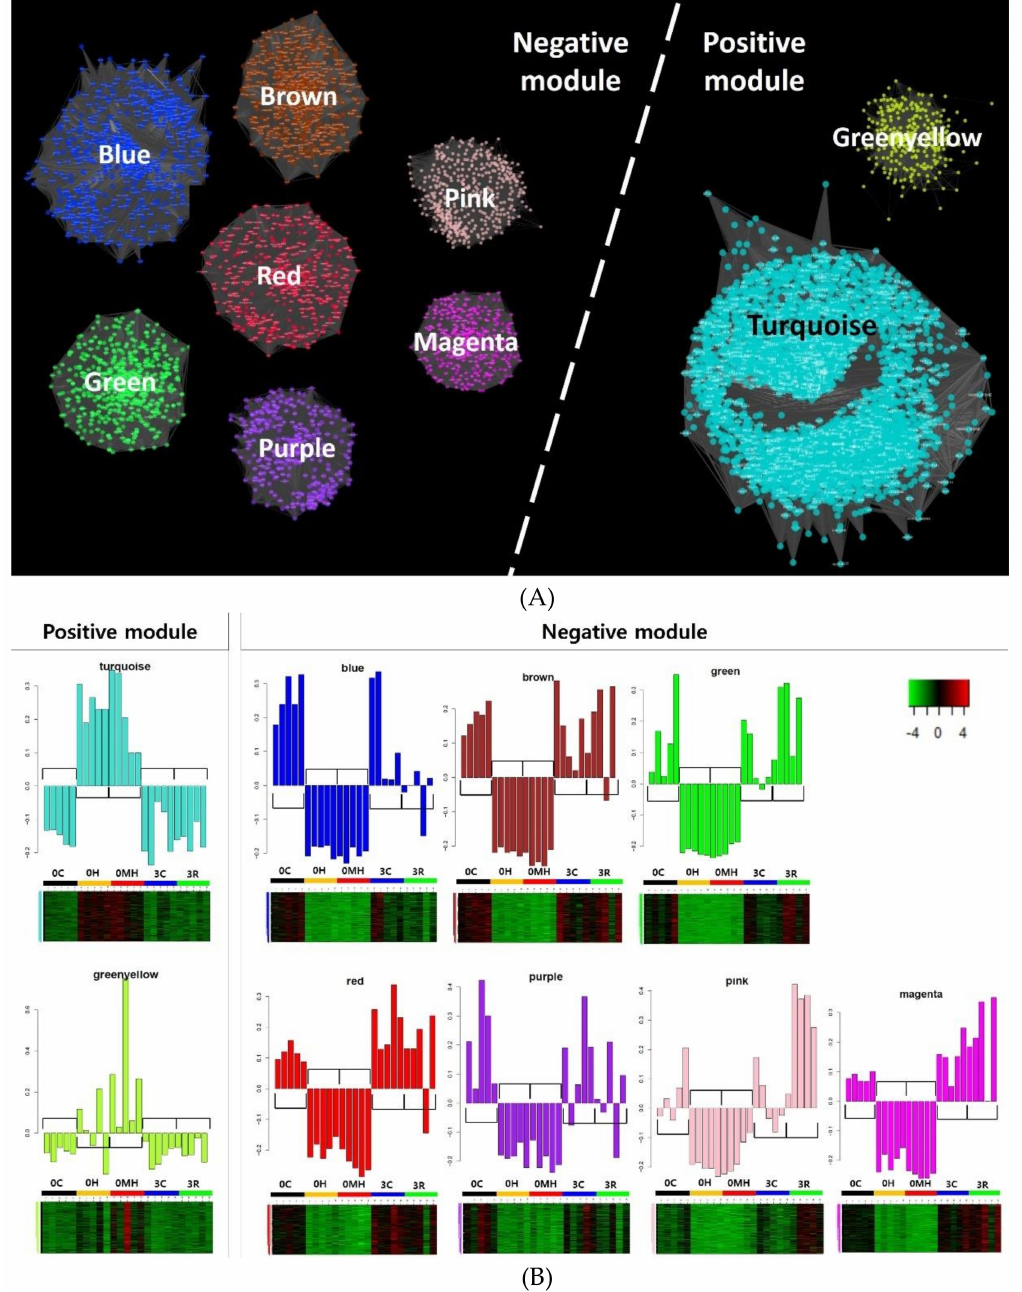
Figure 2. Construction of co-expression network ( A ) and bar graph and heatmap ( B ) representing eigengene expression patterns in selected nine modules ( | GS vs. MM | > 0.5, p -value < 0.05) having positive and negative correlations with splenic viral load. In bar plots, x- and y-axis show samples and module eigengene representing the first principal component of gene expression matrix in each module, respectively. 0C; uninfected healthy fish at week 0 as control; 0H, heavy infected fish at week 0; 0MH, heavy mixed RBIV and bacterial infected fish at week 0; 3C, uninfected healthy fish at week 3; 3L, light infected fish at week